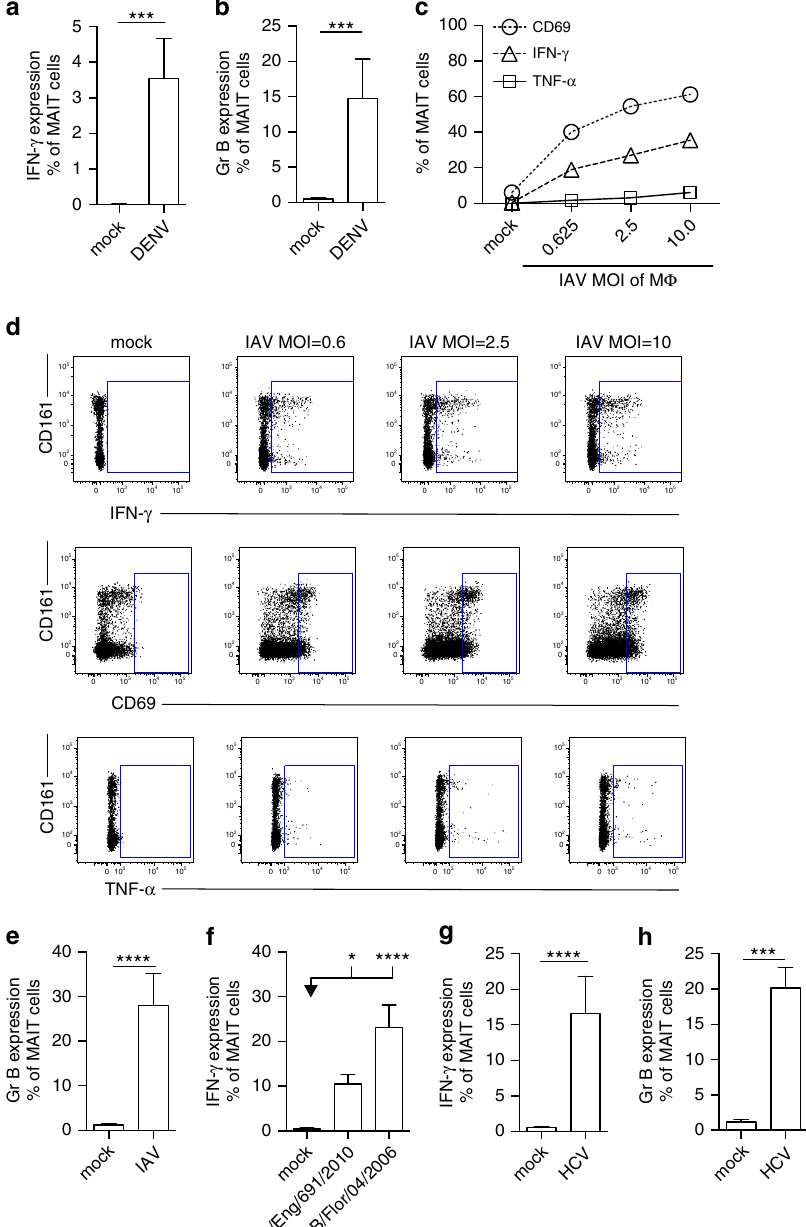
Figure 3 | Viral MAITcell activation in vitro . MAITcells from healthy individuals were analysed by flow cytometry, gated on live CD3 þ CD161 þ þ V a 7.2 þ cells. ( a , b ) PBMC’s ( n ¼ 7) were co-cultured with autologous monocyte-derived DC’s exposed to DENV (MOI ¼ 1) as described in ‘Methods’. ( c – e ) CD8 þ Tcells isolated from PBMC’s ( n ¼ 11–12) were co-cultured with IAV-exposed macrophages (MOI ¼ 1) as described in ‘Methods’, unless indicated otherwise. ( f ) CD8 þ Tcells isolated from PBMC’s ( n ¼ 11–12) were co-cultured with macrophages exposed to the clinical H3N2 influenza A strain (A/England/691/ 2010 ( n ¼ 7)) or influenza B (B/Florida/04/2006 ( n ¼ 8)) (MOI ¼ 1) as described in ‘Methods’. ( g , h ) CD8 þ T cells isolated from PBMC’s ( n ¼ 7–12) co-cultured with macrophages exposed to HCV (MOI ¼ 1) as described in ‘Methods’. Proportion of MAIT cells producing IFN- g ( a , c , d , f , g ), TNF- a ( c , d ), CD69 ( c , d ) or Granzyme B ( b , e , h ). ( d ) Representative flow cytometry plots. All data are representative from at least two independent experiments. Bars represent means ± s.e.m. Statistical significance was determined with the Kruskal–Wallis test followed by the Dunns’ test ( f ) or the Mann–Whitney test ( a , b , e , g , h ). ns 4 0.05, * P 0.05, *** P r 0.001, **** P r 0.0001. Eng, England; Flor, Florida; HC, healthy control; Gr B, Granzyme B; M F , macrophage; REL/NR, relapse/non-response; SC, spontaneous clearance; SVR, sustained virological response; tr.,